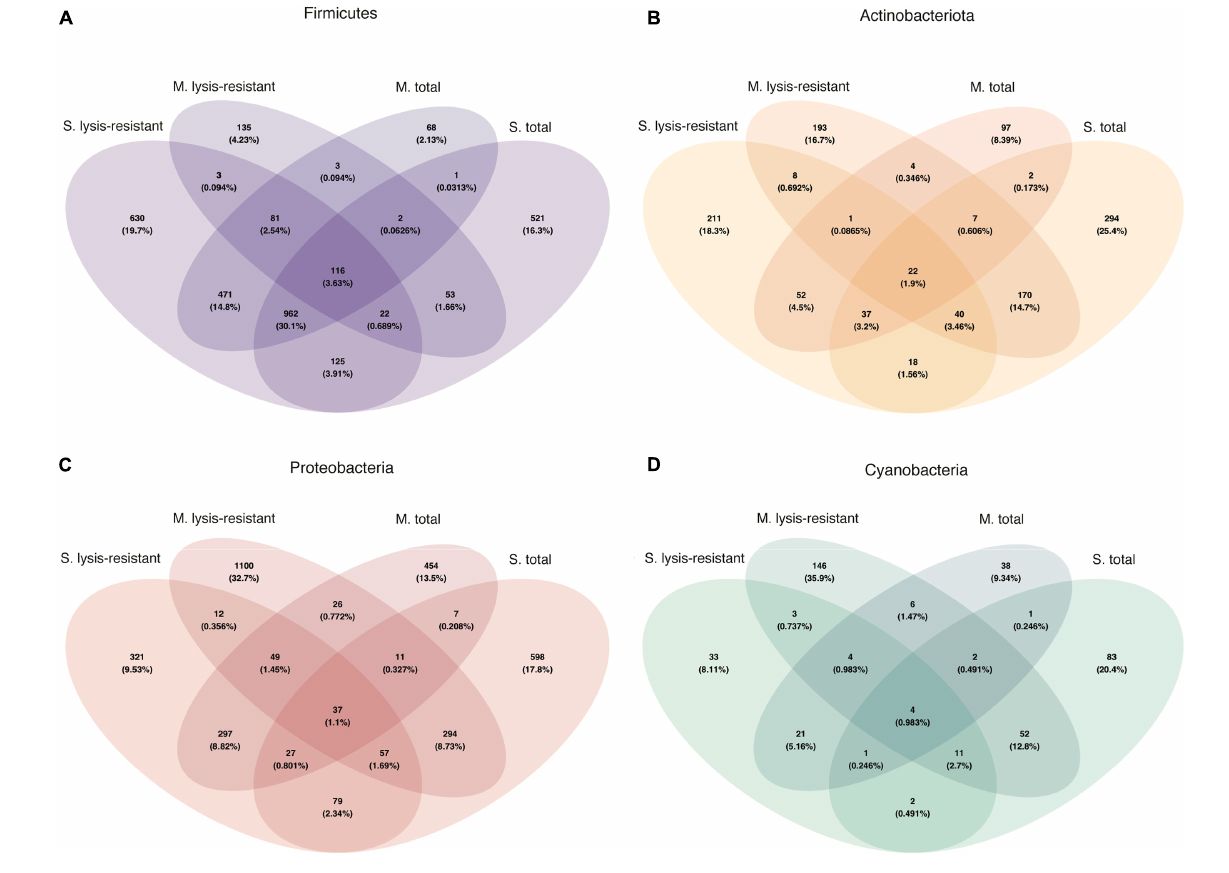
FIGURE 8 | Venn diagram of the bacterial community for each fraction and environment. (A) Firmicutes in the 5,000 top ASVs. (B) Actinobacteria in the 5,000 top ASVs. (C) Proteobacteria in the 5,000 top ASVs. (D) Cyanobacteria in the 5,000 top